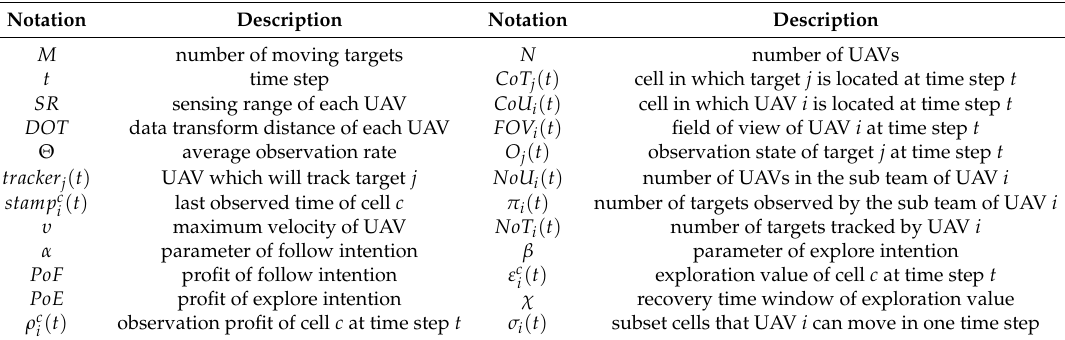
Table A1. Notations used in